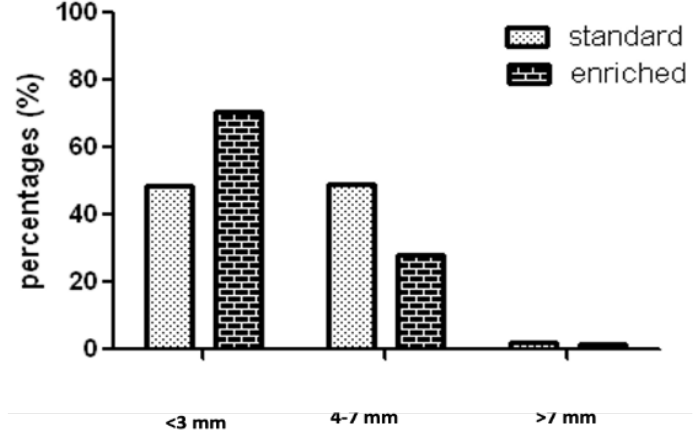
Figure 2. Percentage of small ( < 3 mm), intermediate (3–7 mm) and large ( > 7 mm) polypoid lesions in ApcMin/+ mice assuming standard or enriched diet. Statistical analysis (Chi square for trend, p < 0.001).